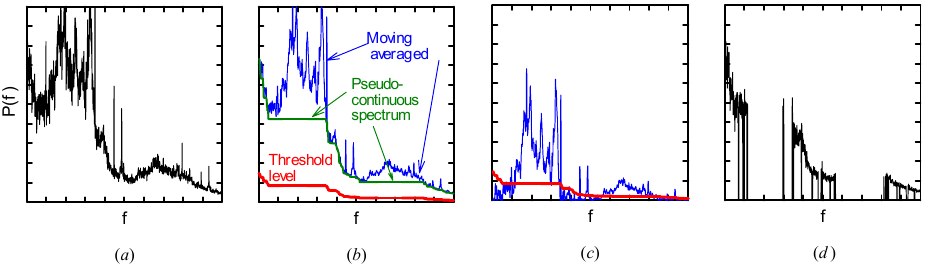
Fig. 16 Schematic diagrams for estimating randomness